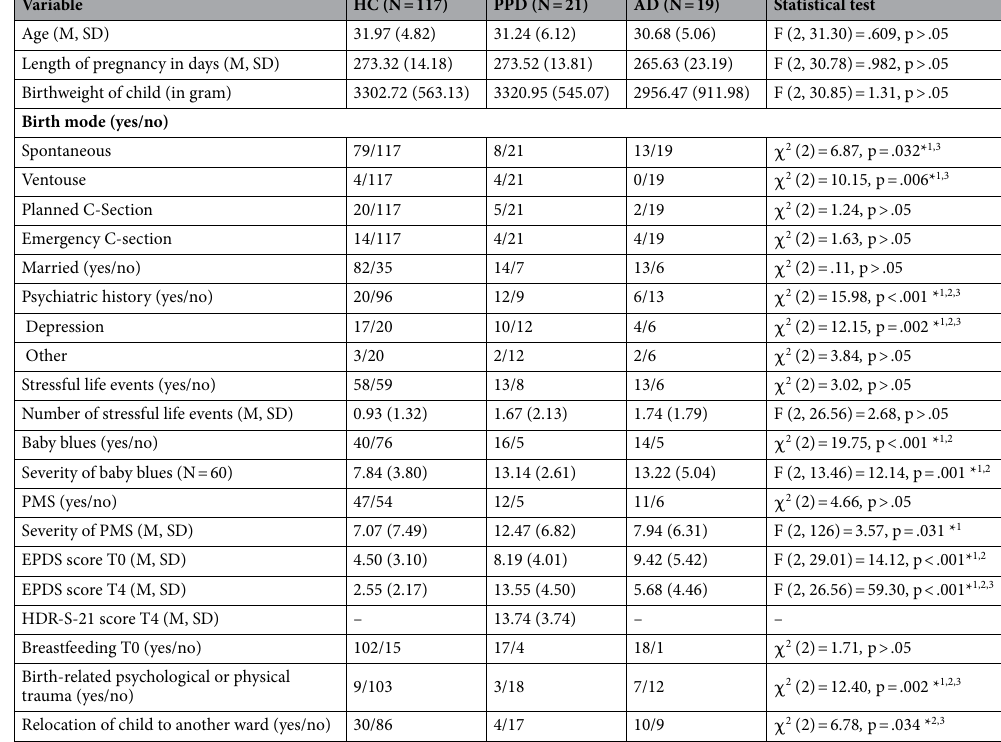
Table 1. Demographic and anamnestic data for all groups. HC healthy controls, PPD postpartum depression, AD adjustment disorder, M Mean, SD Standard deviation, PMS premenstrual syndrome, EPDS Edinburgh